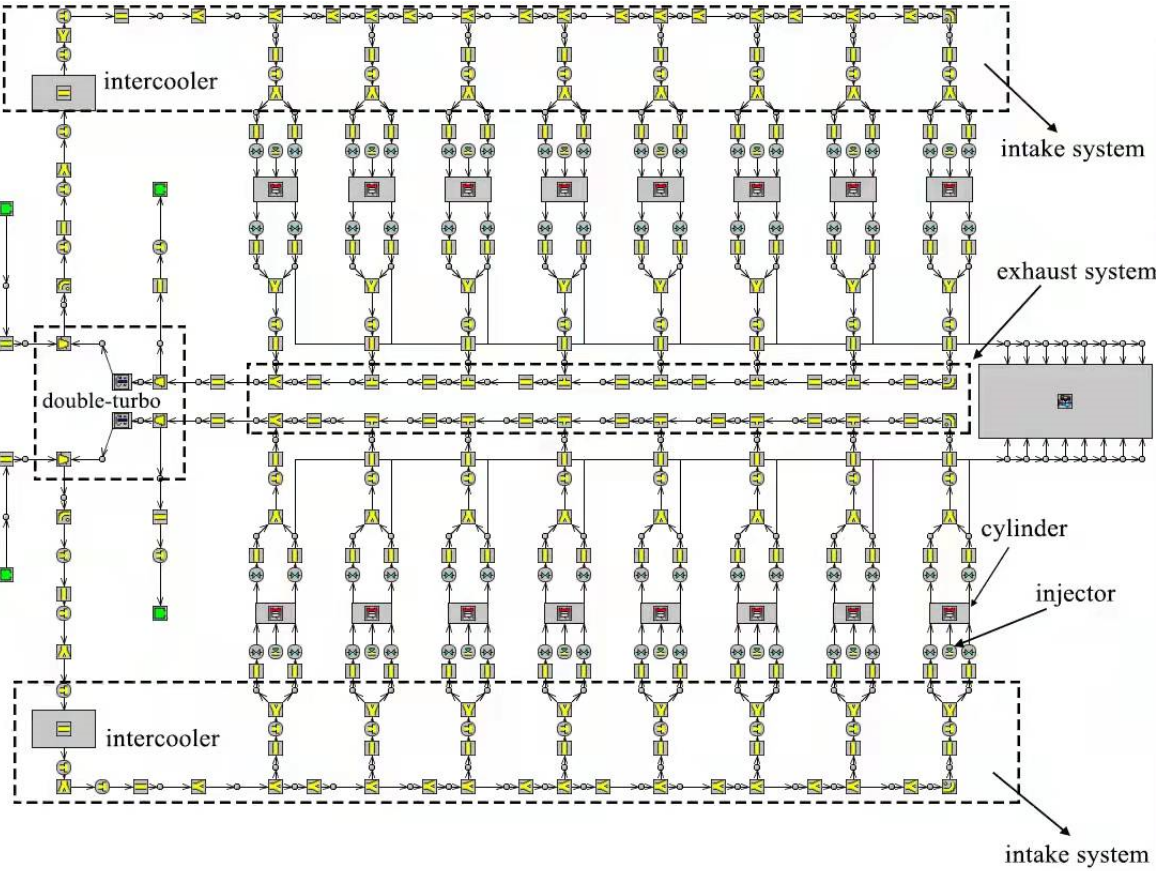
Table 5. The main technical parameters of diesel engine.